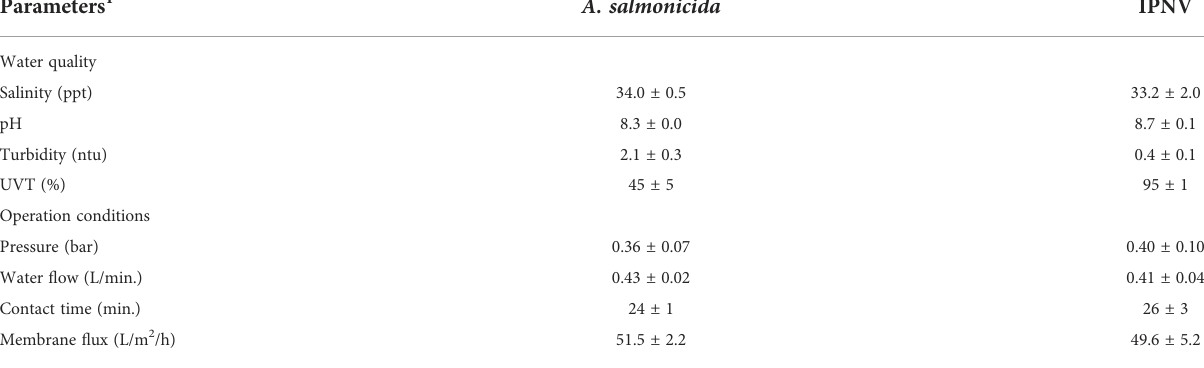
(Figure 1B), and a cylindrical tank number. 2 to collect the membrane permeate. The capillary membrane consisted of 63 fi bres, each fi bre had 7 capillaries with an inner diameter of ® ® 0.9 mm (dizzer modules with Multibore 0.9 membrane, inge GmbH, Germany) and was 50 cm in length measuring a total area of 0.5 m 2 . The membrane material was polyethersulfone and the pore size was appr. 20 nm. The membrane was operated as inside- out fi ltration, i.e., pressured water and particles were forced into the membrane fi bres capillaries where water and particles smaller than 20 nm escape forming the membrane permeate which fl owed to a cylindrical tank number 2. Standard commercial operation settings were used in the tests (Table 1), such as pressure< 1 bar and fl ux ~50 L/h/m 2 .